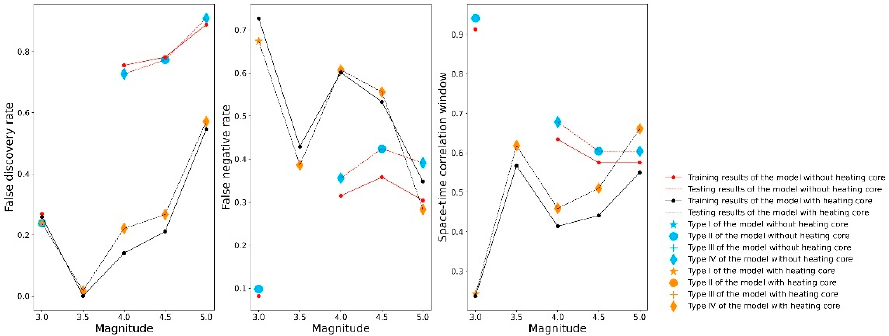
Figure 7. Comparison of the training and test results of the optimal models with/without a “heating core” at different magnitudes when the resampling scale is 100.